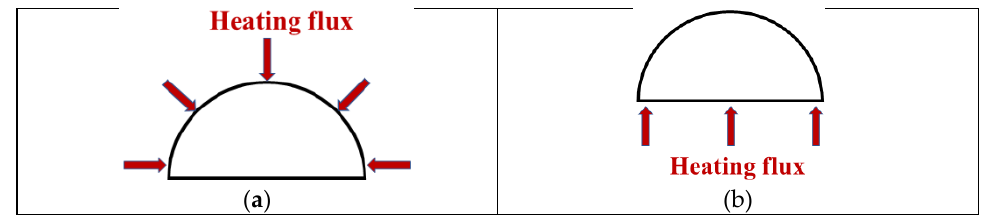
Figure 11. The physical process ( a ) of Equation (21) and the physical process ( b ) of Equation (22). The contribution of λ and λ t to λ eff , along with y + in one local section, is shown in Figure 12.